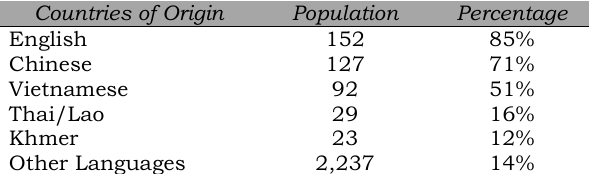
Table 3. Linguistic